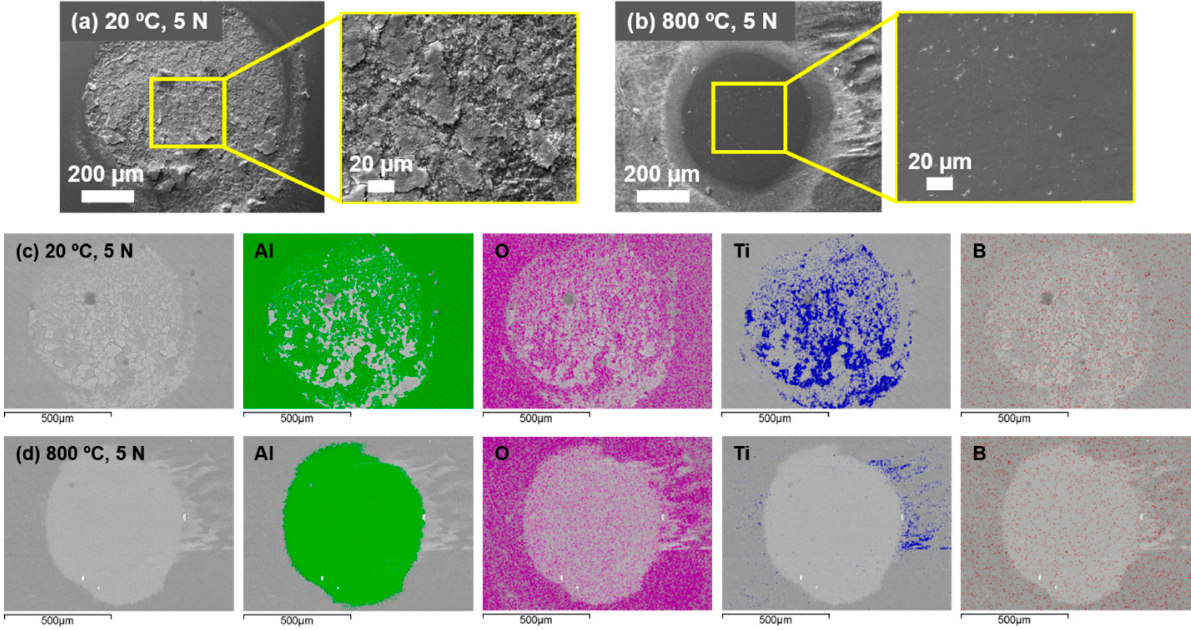
Figure 9. ( a,b ) SEM images of the counterbody ball worn surface; and ( c,d ) energy dispersive spectrometer (EDS) mapping Figure 9. ( a , b ) SEM images of the counterbody ball worn surface; and ( c , d ) energy dispersive spectrometer (EDS) mapping of the worn area of the counterbody tested at 20 °C and 800 °C with load of 5 N. of the worn area of the counterbody tested at 20 ◦ C and 800 ◦ C with load of 5